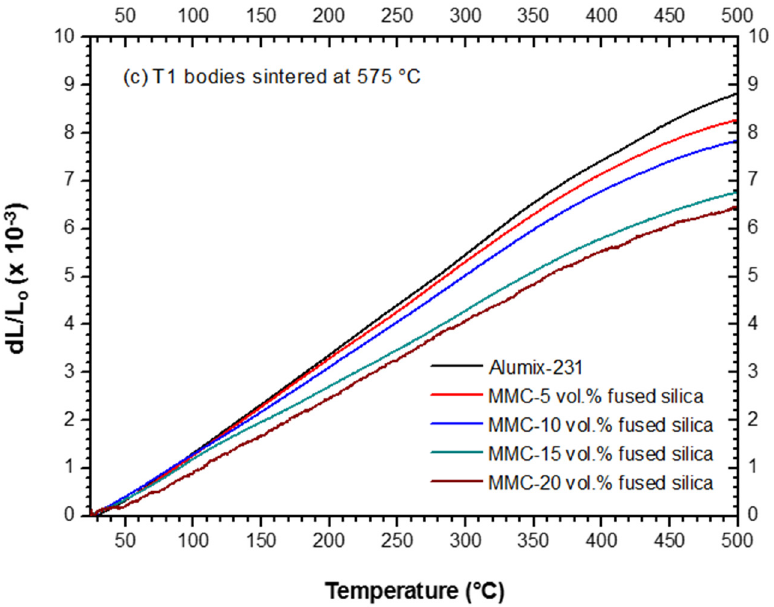
Figure 4. Thermal expansion of neat Alumix-231 and MMCs ( a ) sintered at 565 °C, ( b ) 570 °C, and ( c ) 575 °C.